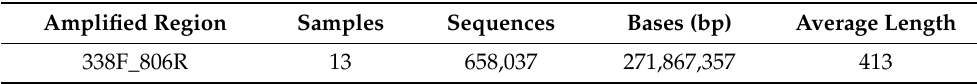
Table 2. Summary of sequencing